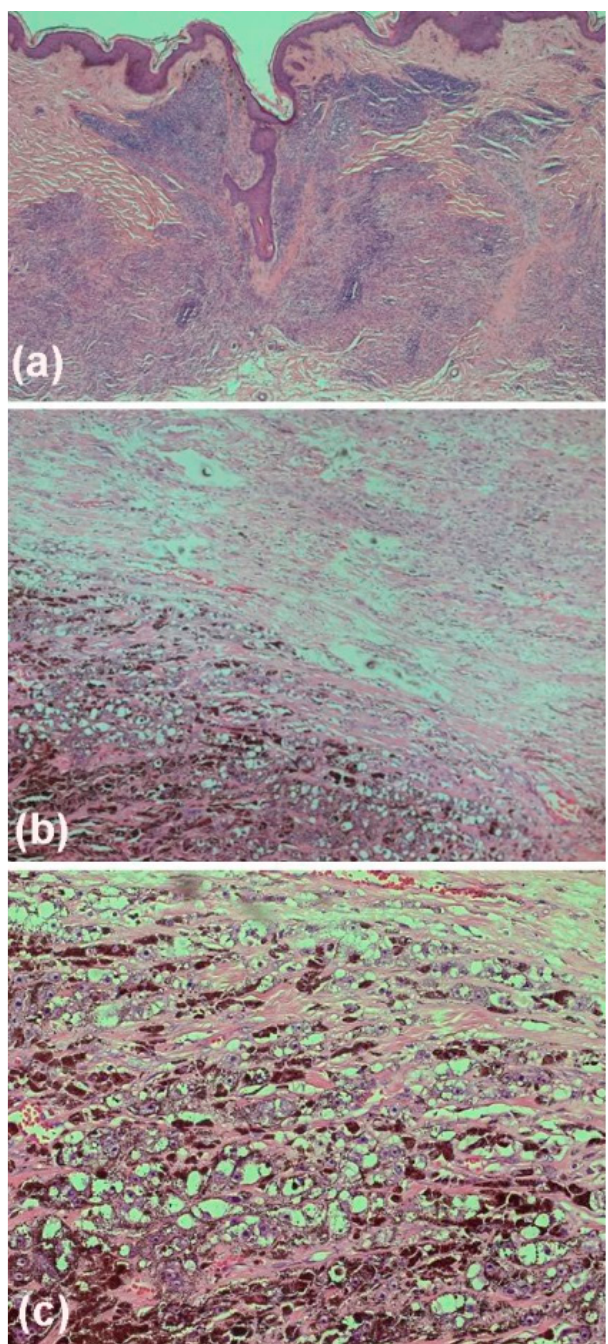
Figure 3. Histopathology of two nodules excised from the lower back and right buttock revealed similar findings, including dermal monomorphic small epithelioid and spindle cell shaped melanocytes and melanophages, reaching down to the subcutaneous tissue ( a ). Underneath there was a partly necrotic nodule including large melanocytes with atypia, prominent nucleoli, and increased and atypical mitoses ( b , c ).